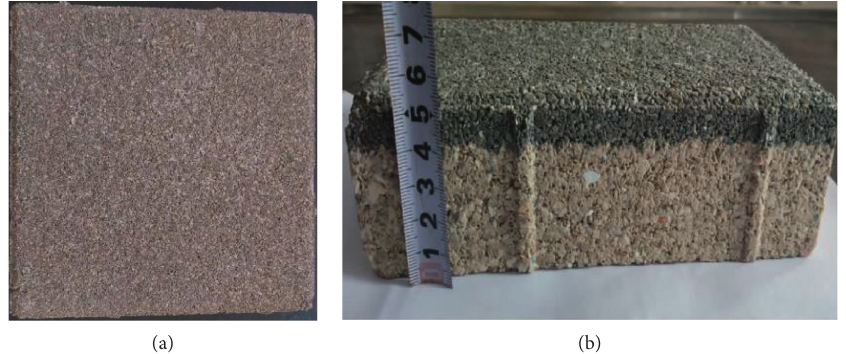
Figure 2: Ceramic permeable brick. (a) Surface. (b) Section.